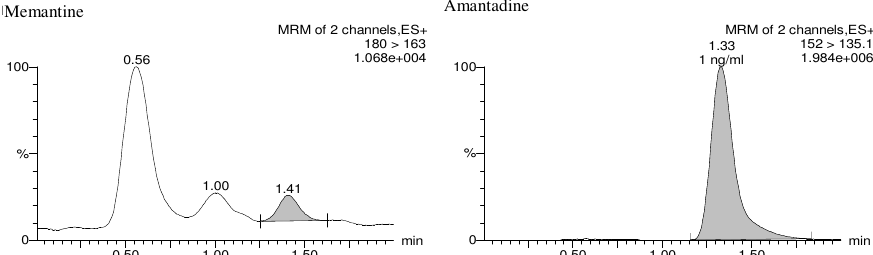
Figure 1. Representative chromatogram of memantine and its internal standard from extracted plasma blank.